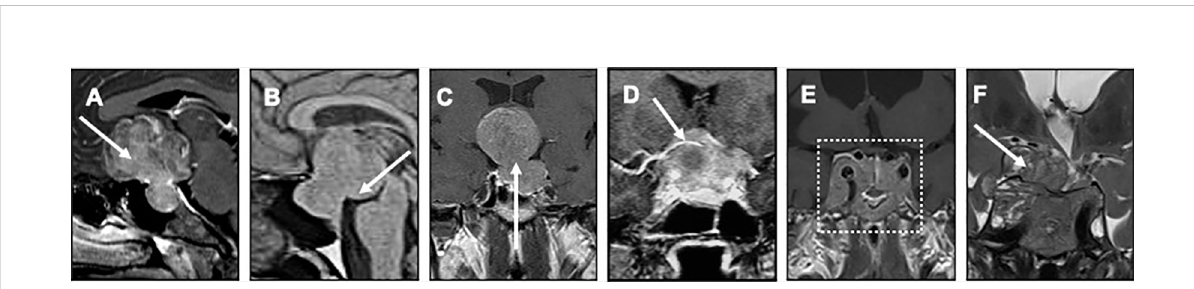
FIGURE 1 Different patterns of giant tumors extension Preoperative pituitary MRI are presented, including gadolinium-enhanced T1 weighted sagittal (A, B) , coronal (C – E) and T2 weighted coronal (F) images. (A) subfrontal extension (white arrow); (B) posterior fossa extension (white arrow); (C) suprasellar extension with a “ narrow neck ” aspect between the intrasellar and the suprasellar tumor components; (D) encasement of the right anterior cerebral artery (white arrow); (E) massive invasive sphenoid tumor bridging the two cavernous sinuses, de fi ned as “ sphenoid arch ” aspect (white dotted rectangle); (F) tumor extension through the roof-top of the right cavernous sinus (white